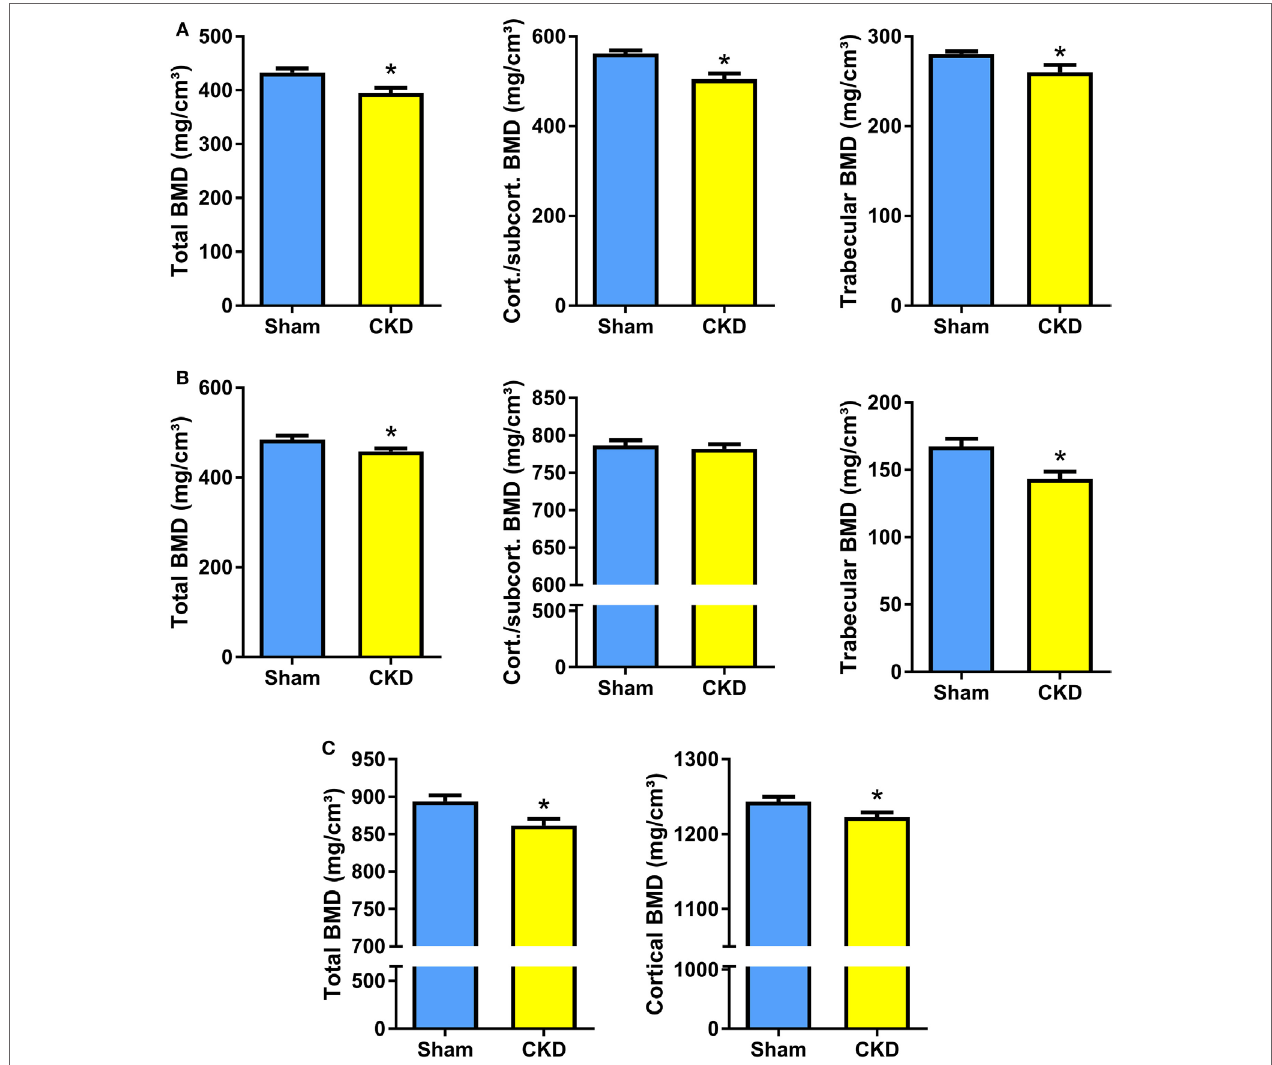
FigUre 2 | Chronic kidney disease (CKD) induces bone loss in the axial and appendicular skeleton. (a–c) Total, cortical/subcortical, and trabecular bone mineral density (BMD) of the L2 lumbar vertebra (17 Sham, 7–9 CKD for each parameter) (a) and of the proximal tibial metaphysis ( n = 16–17 each) (B) , as well as total and cortical BMD of the tibial shaft ( n = 17 each) (c) in 5-month-old male C57BL/6 Sham and CKD mice on rescue diet, 8 weeks postsurgery. Data in (a–c) are mean ± SEM. * P < 0.05 vs. Sham by t -test or Mann–Whitney U -test as